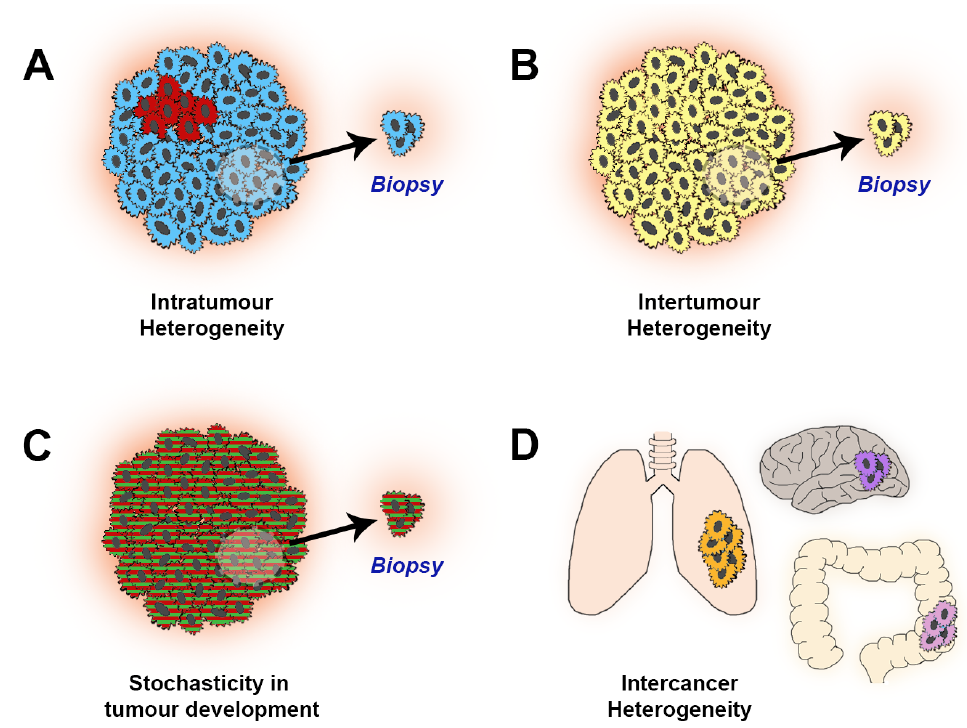
Figure 1. Intra-tumour heterogeneity and prognostication. ( A ) Intra-tumour heterogeneity means a targeted biopsy may miss a lesion with a poor prognostic signature (“red” phenotype) within the tumour (majority of tumour has a “blue” phenotype that is associated with a good prognosis). ( B ) Differences between tumours (inter-tumour heterogeneity) mean that a single prognostic biomarker may be unsuitable for use in some tumours that have evolved along a different carcinogenic pathway; this yellow tumour does contain either the previously identified good (blue) or bad (red) phenotypes. ( C ) Epistasis between genes (or other intra- or inter-cellular interactions) can alter the prognostic value of any individual feature; here, the presence of the “green” mutation may alter the bad prognosis of the “red” mutation assayed in ( A ). ( D ) Inter-cancer heterogeneity means that a feature-based prognostic marker developed for one cancer type is unlikely to work in another cancer